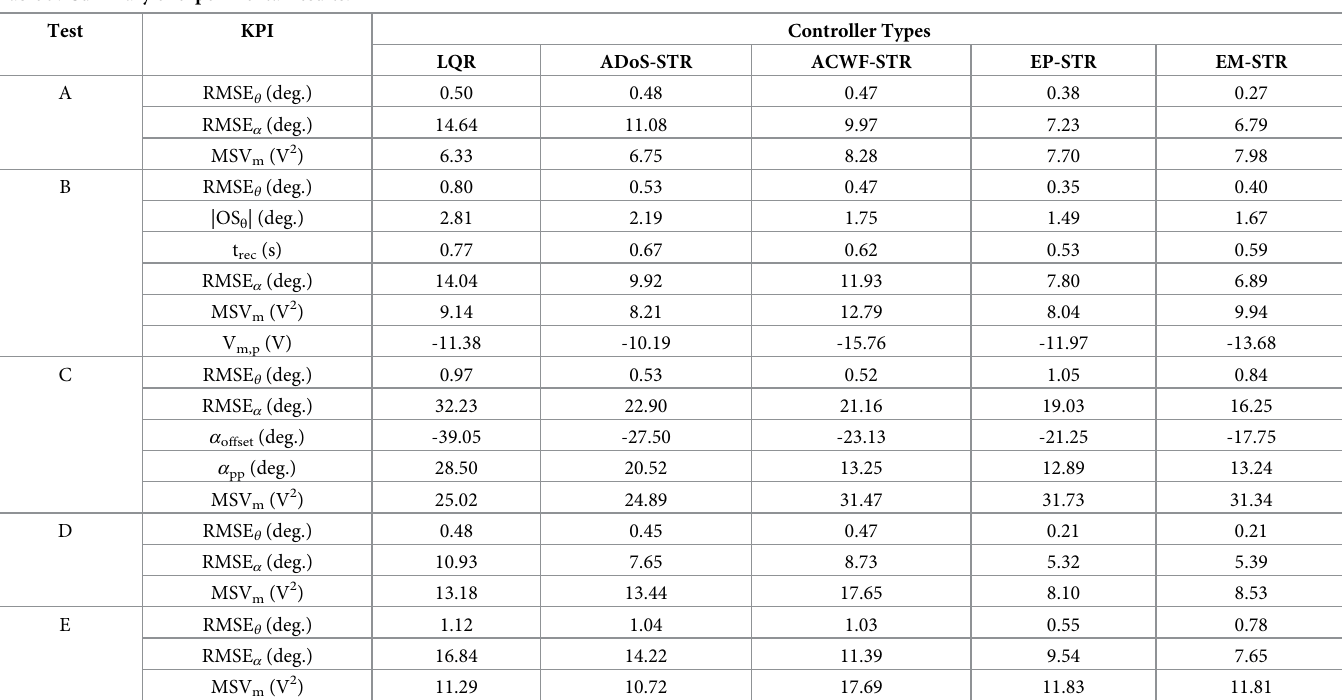
Table 7. Summary of experimental